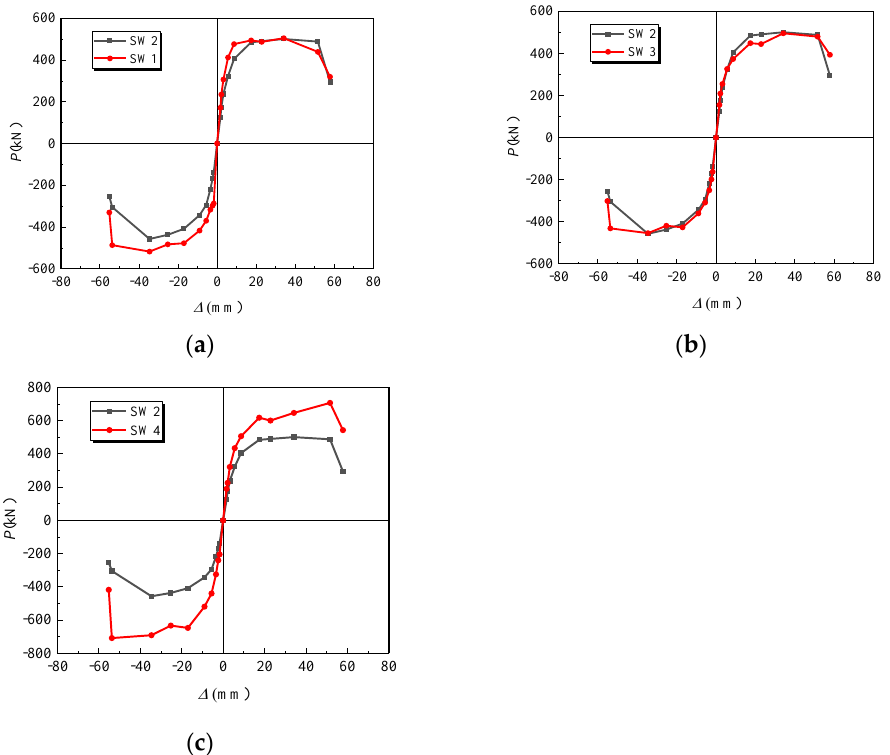
Figure 16. Envelope curves of specimen. ( a ) Fire exposure time; ( b ) Fire-retardant coating; ( c ) The width-thickness ratio.